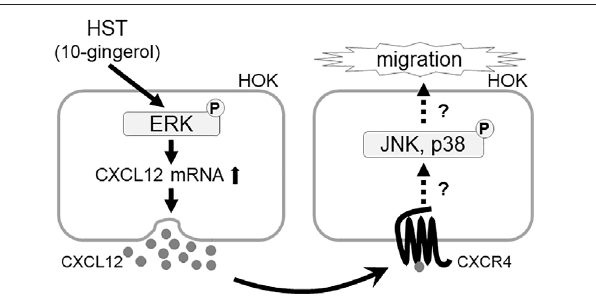
FIGURE 6 | Schematic diagram showing the mechanism of the Japanese herbal medicine HST inducing oral keratinocyte migration by mediating the expression of CXCL12 through the activation of ERK. HST inducesERKphosphorylationandupregulatesCXCL12,whichactivates its receptor CXCR4, and induces cell